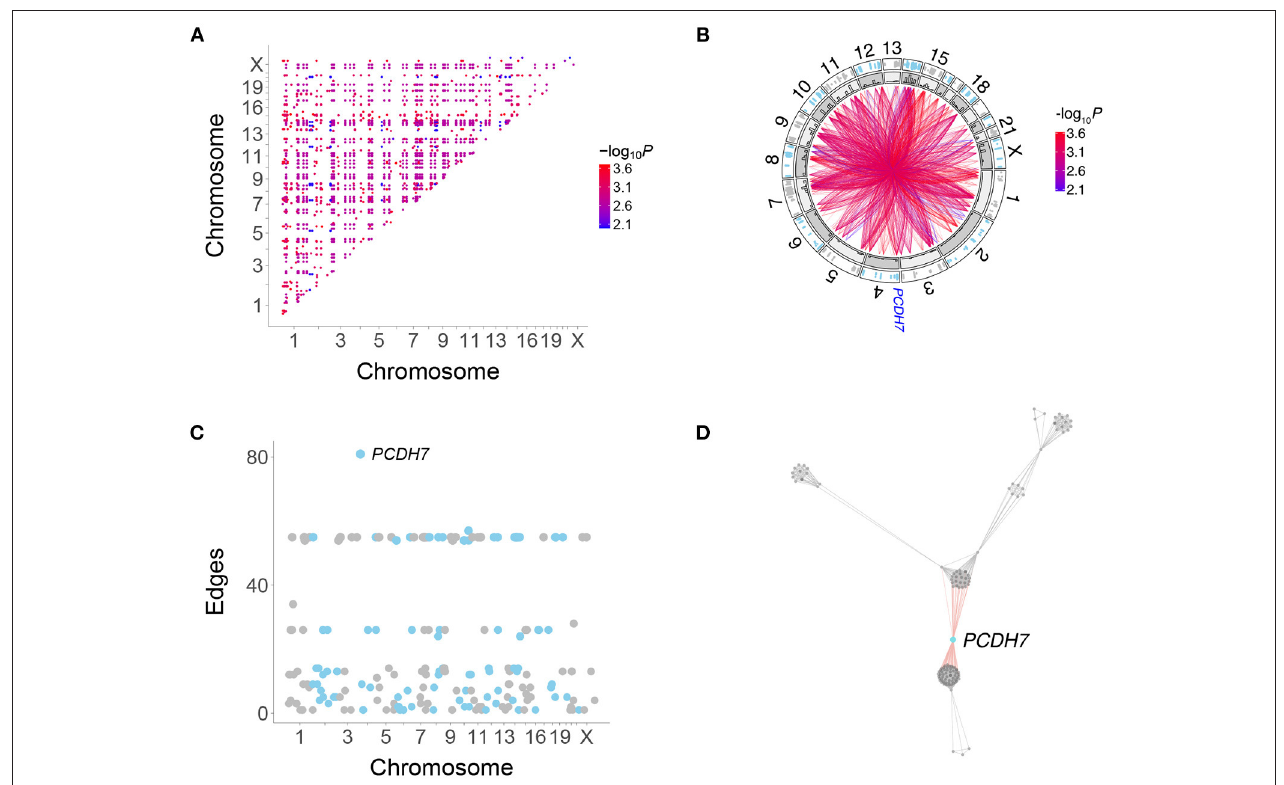
FIGURE 3 | Human genetic interactions. (A) Location and significance of interactions. (B) Circos plot of interactions. Outer track, location of interacting genes; inner track, histograms of interaction numbers normalized for each chromosome. Location of PCDH7 on Chromosome 4 shown. (C) Number of interactions for each gene. PCDH7 has the most. (D) Subnetwork featuring PCDH7